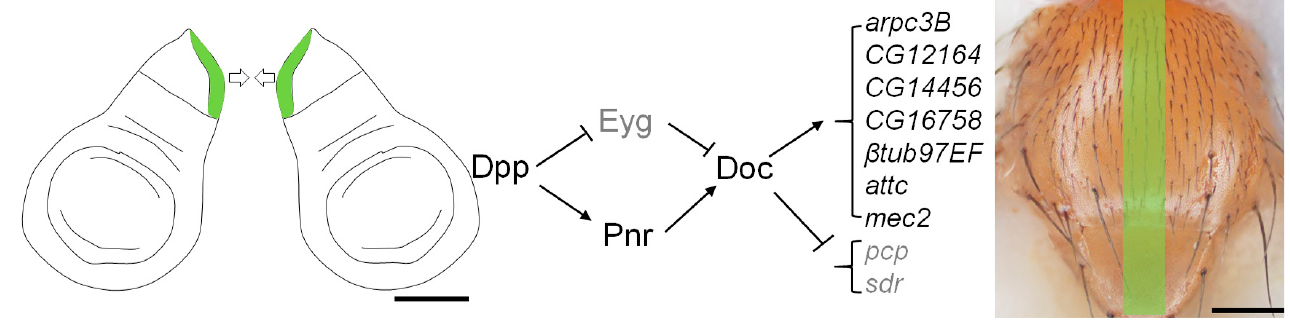
Figure 5. Summary of the signaling pathway regulates the thorax closure. Scale bars, 2 µ m ( left ); 200 µ m ( right